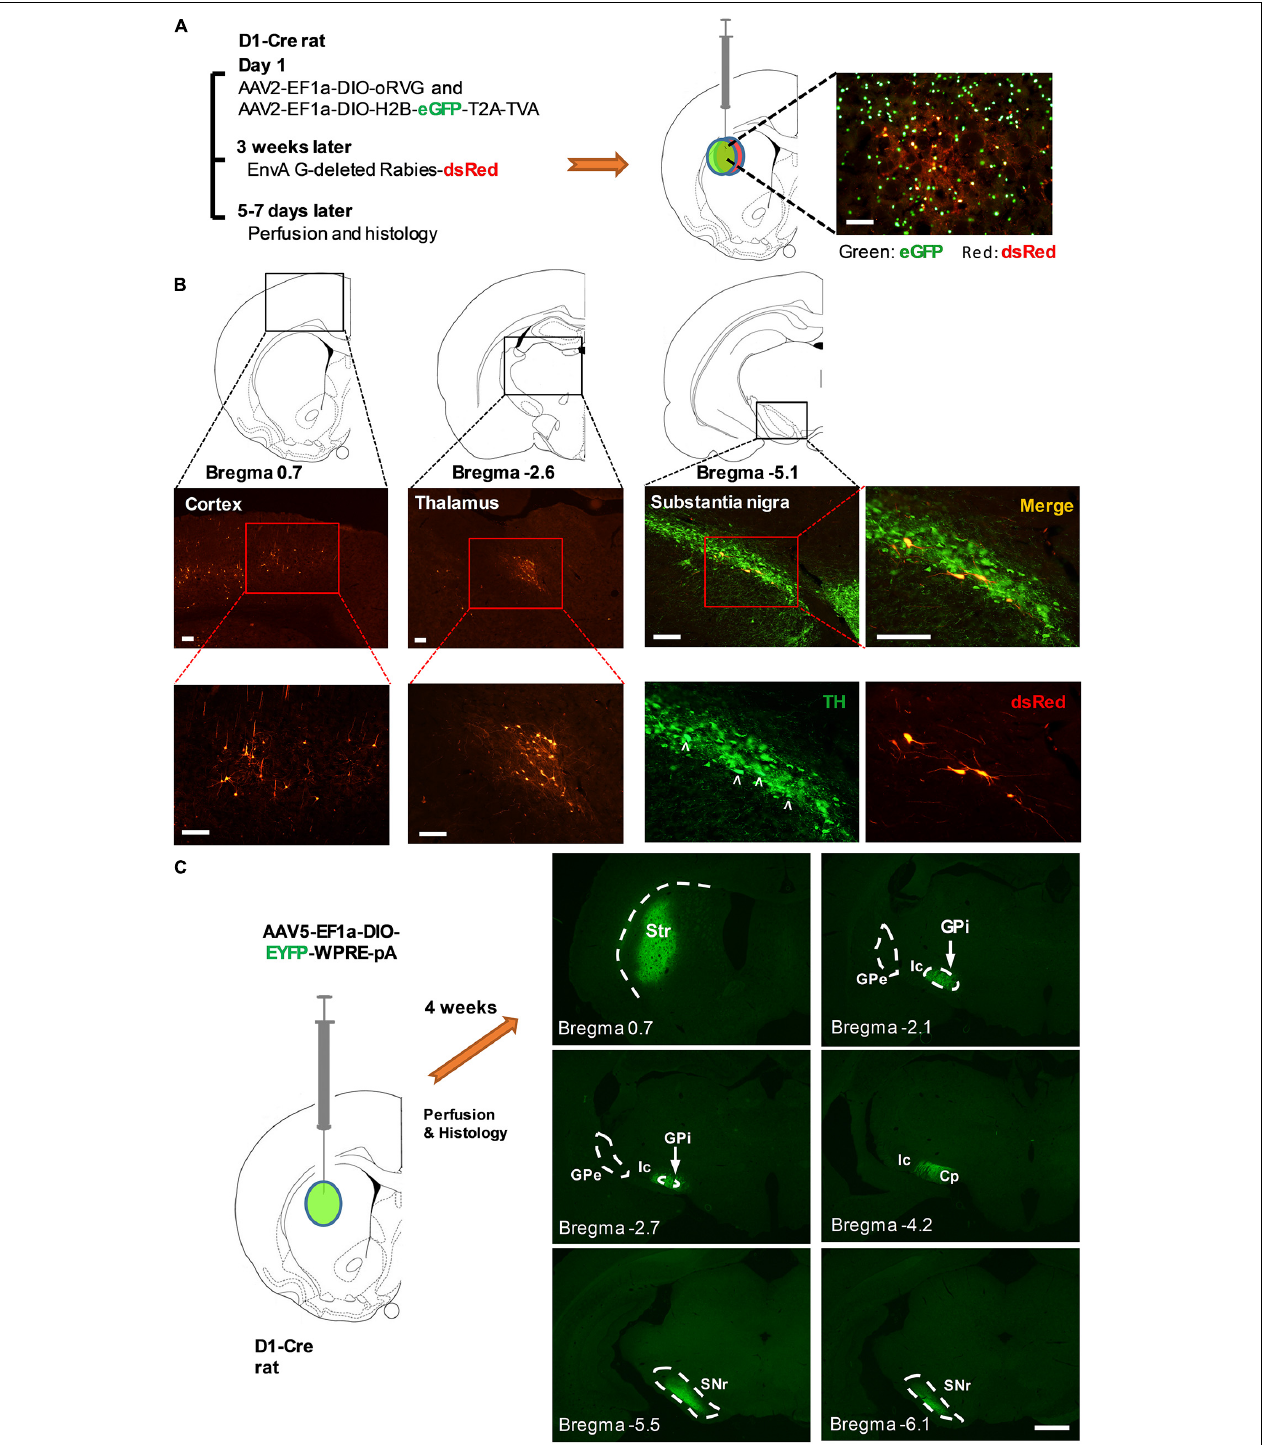
FIGURE 4 | Striatal D 1 -Cre + neurons received monosynaptic inputs from multiple brain regions and sent fibers directly to the major output nuclei of the basal ganglia. (A) Diagram illustrating the procedure of virus injection for monosynaptic retrograde rabies virus tracing (left). Striatal D 1 -Cre + neurons expressing eGFP and dsRed as starter cells for retrograde tracing (right). (B) Major brain regions that send monosynaptic innervation to Striatal D 1 -Cre + neurons including the cortex (left), thalamus (middle), and the substantia nigra pars compacta (right). TH: tyrosine hydroxylase, scale bar = 200 µ m. (C) Fluorescent nerve terminals from striatal D 1 + neurons. Striatal D 1 + neurons were labeled using the injection of AAV5-EF1a-DIO-EYFP-WPRE-pA in the striatum of D 1 -Cre rats. Str, striatum, GPi, internal globus pallidus, GPe, external globus pallidus, Ic, internal capsule, Cp, cerebral peduncle, SNr, substantia nigra pars reticulata (scale bar = 1,000 µ m).